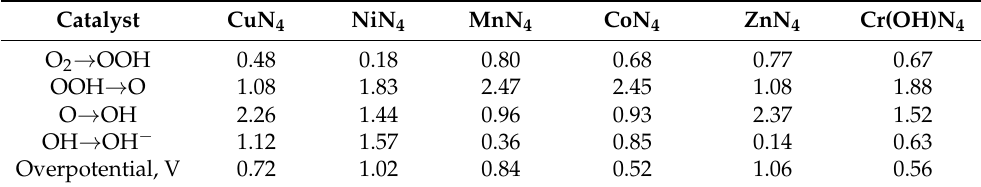
Table 3. Free energy release on the elementary reaction stages of ORR